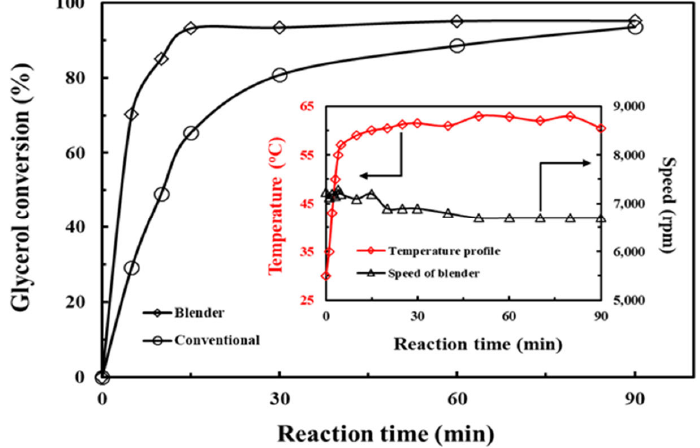
Figure 3. Comparison performance of kitchen countertop blender vs. conventional process on glycerol conversion. Reaction condition: molar ratio of DMC: glycerol = 2.5, reaction temperature = 60 °C, reaction time = 90 min. The inset is the reaction temperature history and blender speed history.